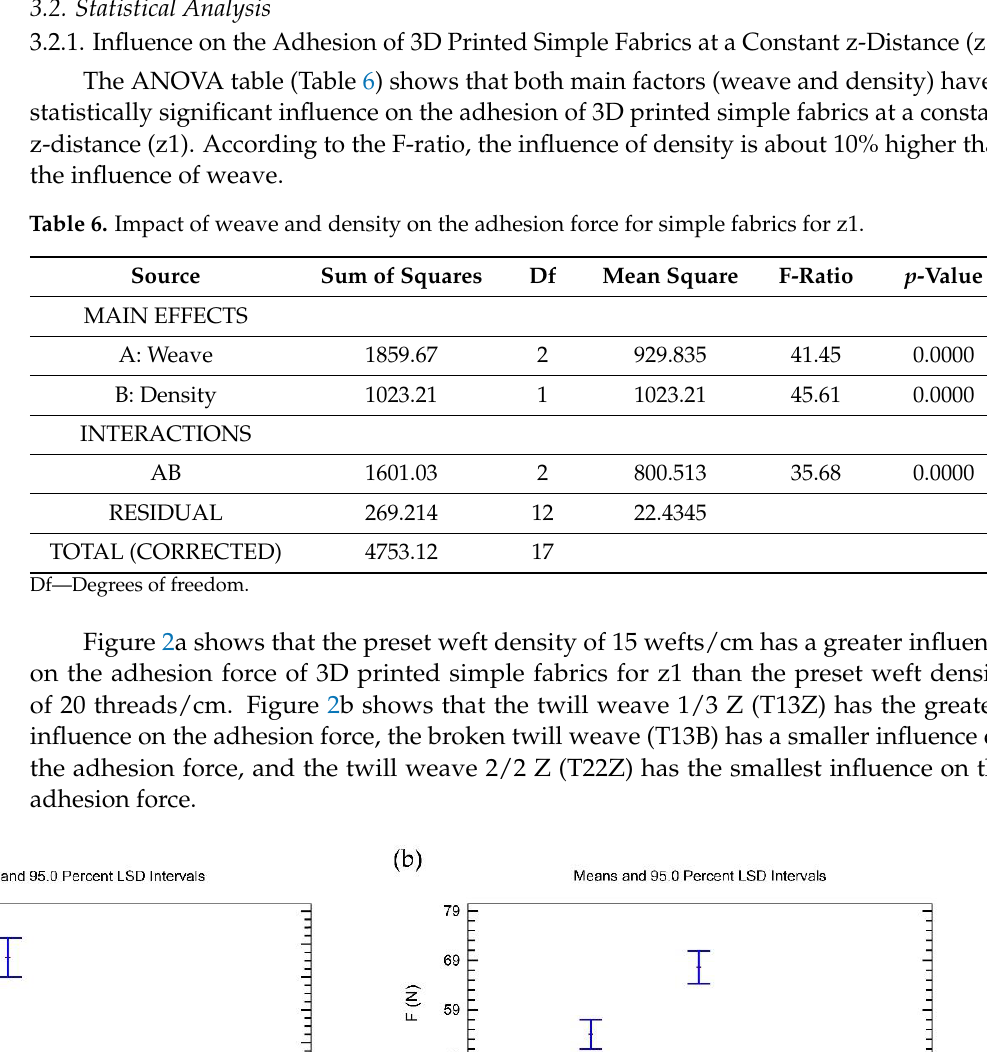
Table 6. Impact of weave and density on the adhesion force for simple fabrics for z1.